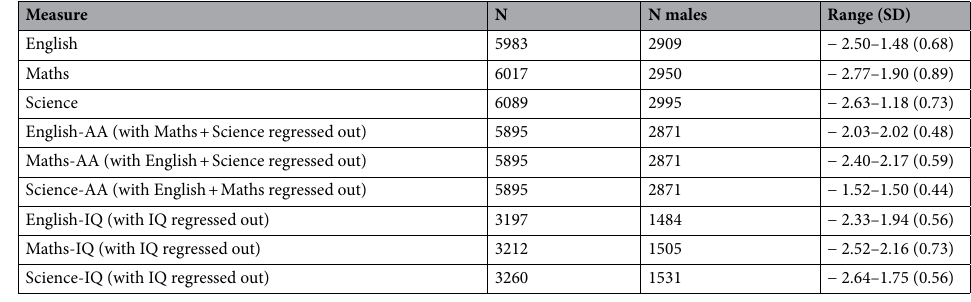
Table 7. Sample descriptive statistics. Academic attainment scores are the sum of residuals from age and sex regressed linear models of individual SAT scores at age 11 (Key Stage 2) and 14 (Key Stage 3). Attainment in other subjects (e.g. English-AA) or IQ (e.g. English-IQ) were then regressed out to provide AA and IQ regressed scores to assess independent genetics